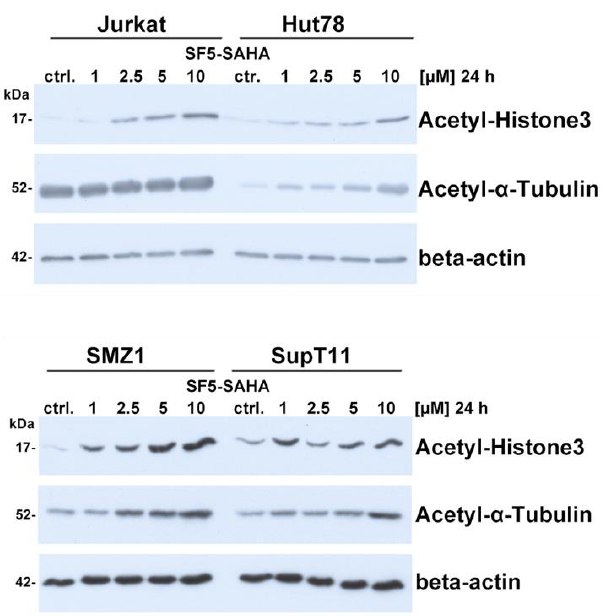
Figure 5. HDAC inhibitory effects of SF5-SAHA in cancer cells. ( A ) HDAC activity was measured by luminescence display of the acetylation state of histones. HeLa nuclear cell extracts, used as source for histones, where preincubated with substrate and inhibitor. Results are given as relatives to controls, not preincubated with inhibitor, as means ± SEM of n = 3 independent experiment. ( B ) Representative Western blot out of n = 3 experiments, showing changes in the expression of acetylated histone H3 after 24 h treatment with compounds in DU145 (left) and Hep-G2 (right) cells. ( C ) From the Western blots gray intensity, mean ± SEM, of acetylated histone H3 specific bands where quantified adjusted to protein loading and normalized to untreated control. * p ≤ 0.05, **** p ≤ 0.0001; 2-way ANOVA Dunnett’s post-hoc test.